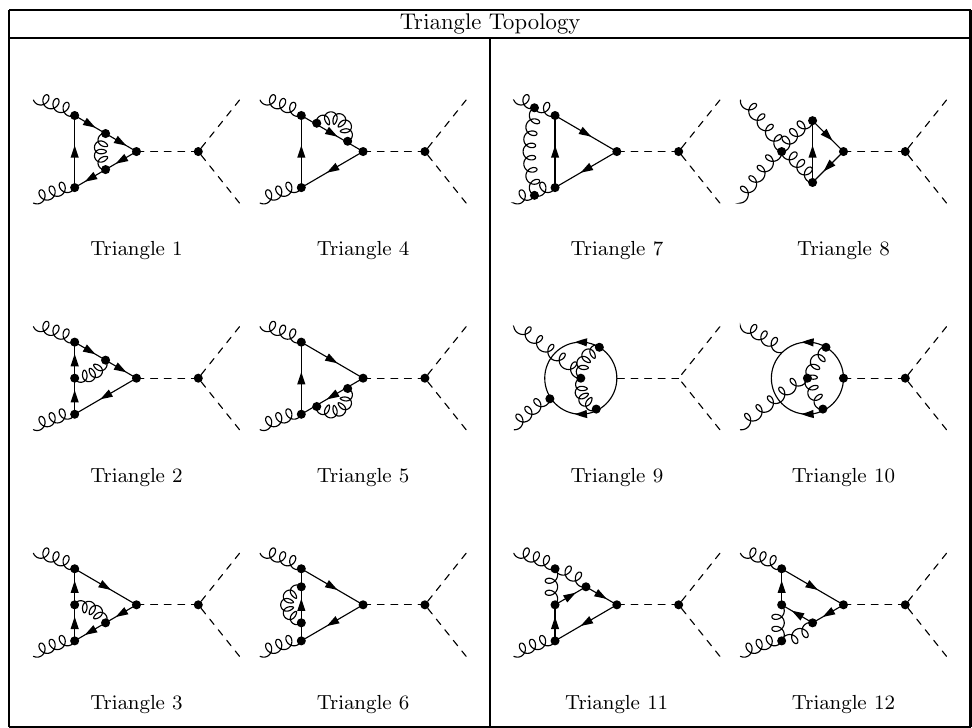
Figure 3 . Two-loop triangle diagrams contributing to Higgs-pair production via gluon